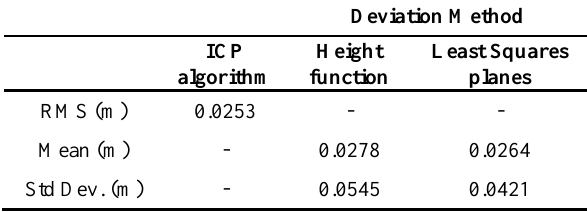
Table 1: Results of the ICP registration and the residual deviations of the point cloud comparison for the i- MMS system.